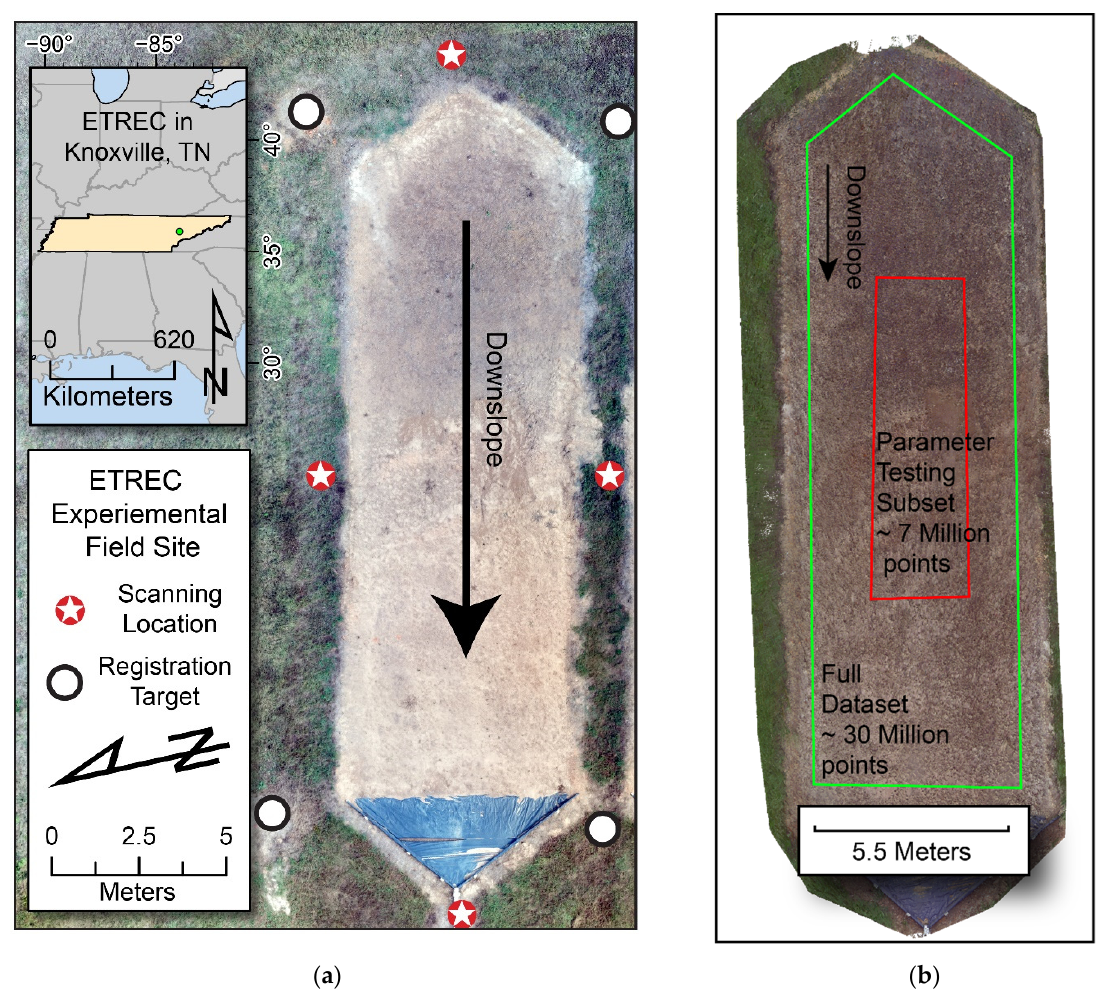
Figure 1. ( a ) East Tennessee Research and Education Center (ETREC) study site. ( b ) Full testing dataset and a spatial subset of the testing dataset used to analyze parameters and models.